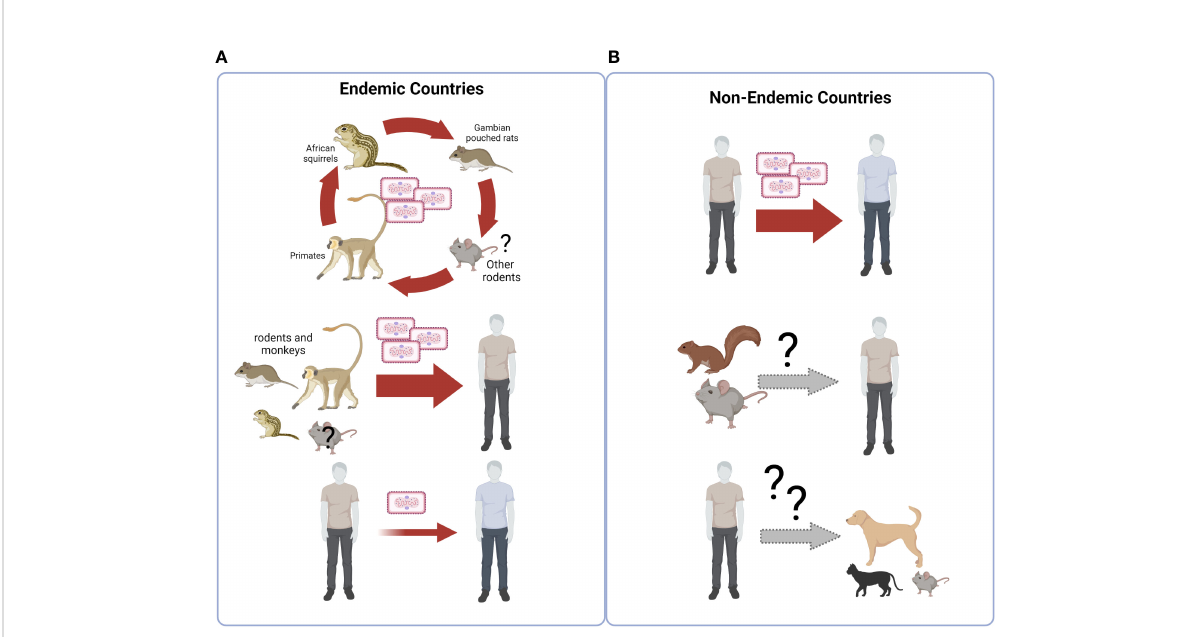
FIGURE 2 Ecology of Monkeypoxvirus. (A) The virus is endemic in over 11 countries of Equatorial Africa, where its circulation is primarily maintained through spread among sylvatic animals, including primarily rodents such as rope squirrel, tree squirrel, Gambian pouched rat and dormice. Monkeys can also be infected. Occasional transmission to humans occurs from animals encountered during hunting, preparation and consumption of bush meat, forest exploration and agricultural activities. Human-to-human transmission is less frequent. (B) In non endemic countries, an outbreak of human MPX cases is currently going on, characterized by sustained human-to-human transmission, occurring through intimate contact with body (including genital) secretions, cutaneous lesions, respiratory droplets and contaminated fomites. Transmission from humans to sylvatic/peri-domestic rodents, or to domestic pets, has not been documented so far, but could represent a potential risk for MPXV endemization in the fauna of new countries outside of Africa. Created with